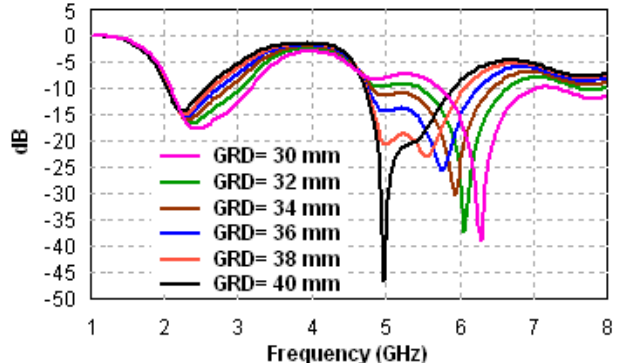
Figure 10: The S 11 responses of the 3rd iteration Koch fractal monopole antenna of Figure 6(b) with GRD as the